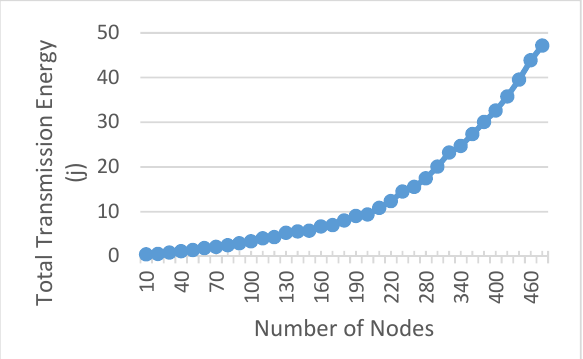
Figure 10. The total transmission energy vs. the number of nodes in the PoW model.